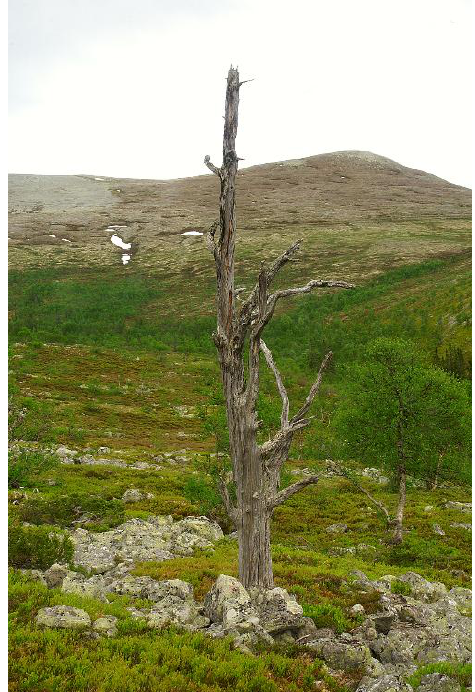
Fig. 6. Pine snag with more than 500 tree-rings and which obviously died during the Little Ice Age. Today, living pines of this dimension do not exist, neither at this elevation nor at the current treeline. Mt. Sonfjället, 875 m a.s.l. Photo: Leif Kullman, 10 June